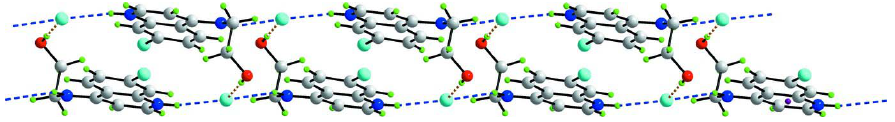
Figure 2 A view of the supramolecular chain along [1 0 1] in (I) showing O—H···Cl - and N—H···Cl - hydrogen bonds as orange and blue dashed lines,